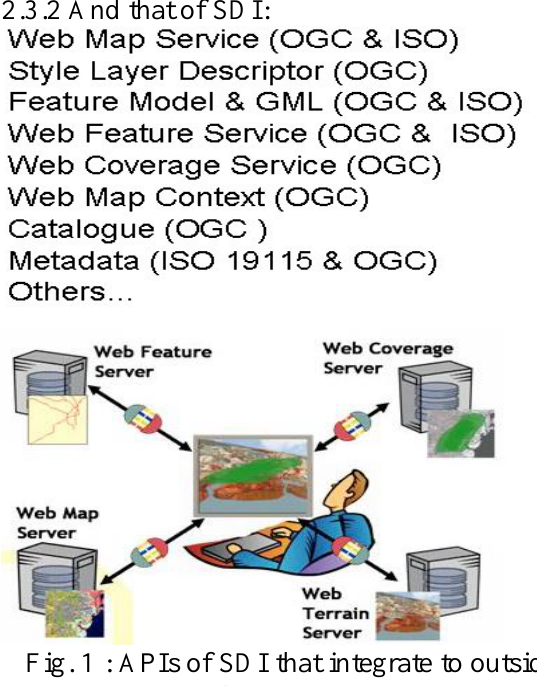
Fig. 1 : APIs of SDI that integrate to outside frameworks.